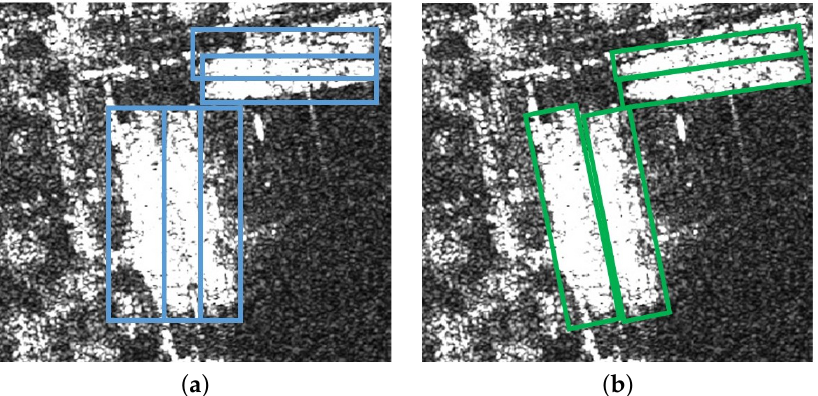
Figure 1. Comparison of the different bounding boxes for locating the oriented ship targets. ( a ) HBB; ( b )